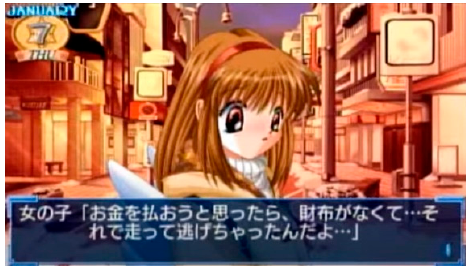
Figure 1. An example from Kanon (Key 1999). The screen composition of bish ō jo games consists of 2D characters in the medium plane between a 2D illustrated landscape in the background and a text box in the foreground. Words in the text box are meant to be what the character is saying: “I was going to pay money but had no wallet… so I just ran away…” Used with permission.